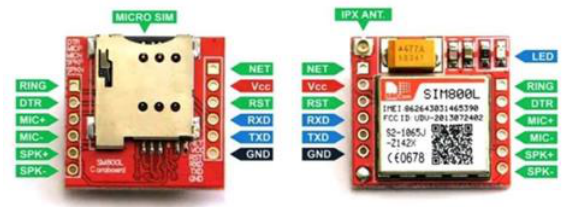
Figure 2. SIM800L Mini GSM/GPRS module.